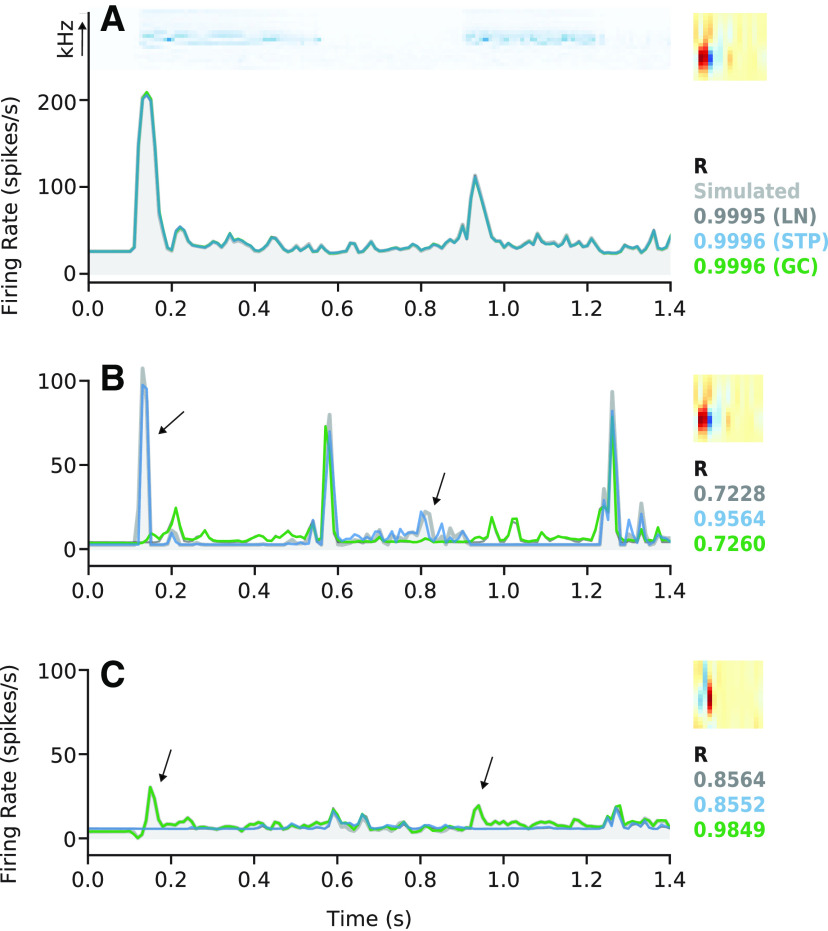
Model performance for simulated data. A, Simulation based on the fitted LN model from Figure 3A. Simulated PSTH response to one stimulus (spectrogram at top) based on an LN model is plotted in gray shading. Predicted PSTHs for each model (LN, STP, or GC) are overlaid, and model prediction correlation is indicated at right (LN: dark gray, STP: blue, GC: green). For this linear neuron, all three models perform nearly identically. The linear filter fit using the LN model is shown at the top right. B, Model fits for simulation based on the STP model from Figure 3B, plotted as in A. C, Model fits for simulation based on the GC model from Figure 3C.